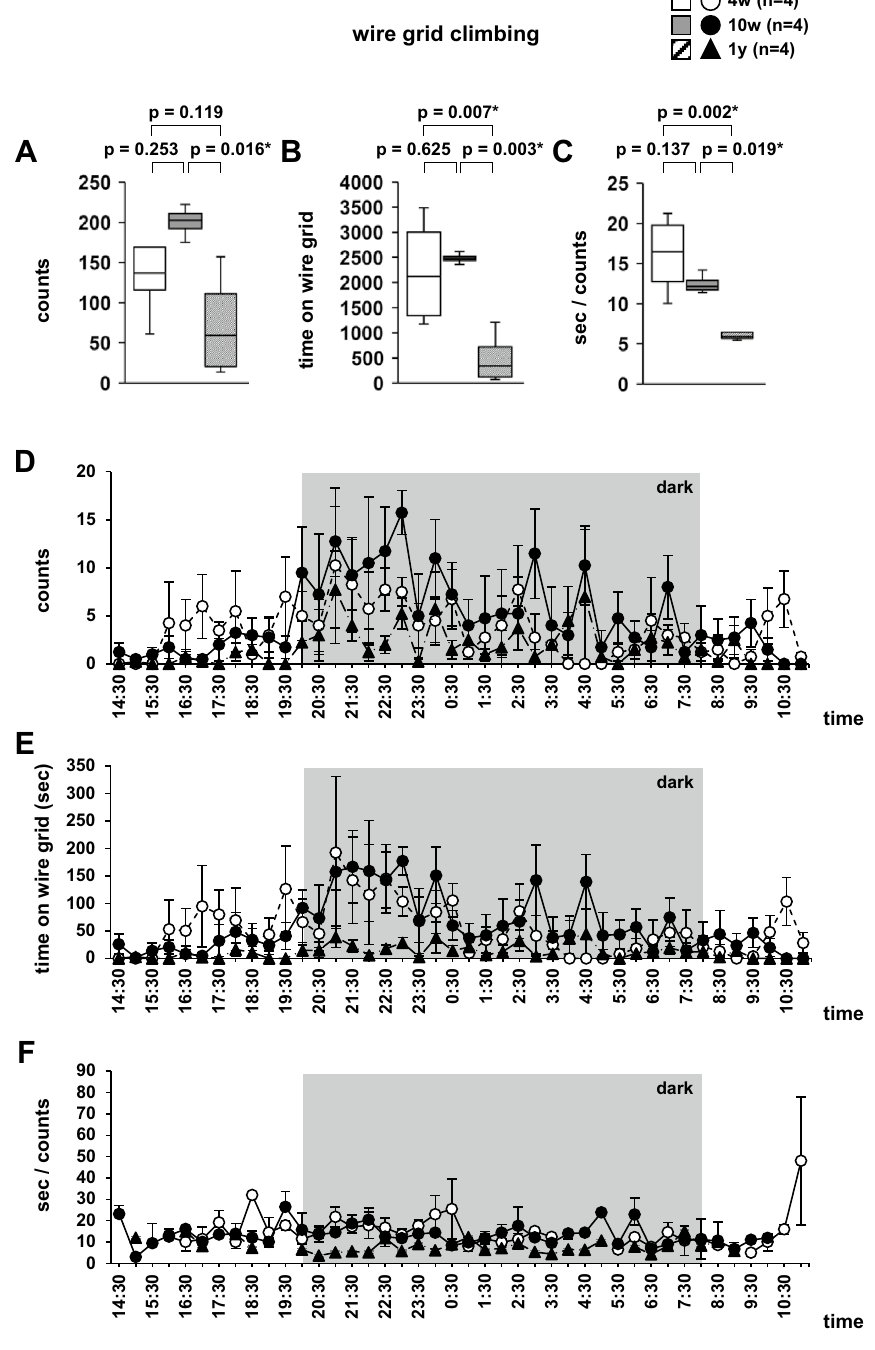
Figure 8. Wire grid climbing in the home cage. Graphs displaying the total number of episodes of grid climbing ( A ), total time spent grid climbing ( B ), mean time per grid-climbing episode ( C ), number of episodes of grid climbing in each 30 min period ( D ), time spent grid climbing in each period ( E ), and mean time per grid- climbing episode in each period ( F ). Data are presented as box plots ( A – C ) or mean ± standard error ( D – F ). Statistical significance is represented by asterisks: * p < 0.05, + p < 0.1. P -values were calculated using the